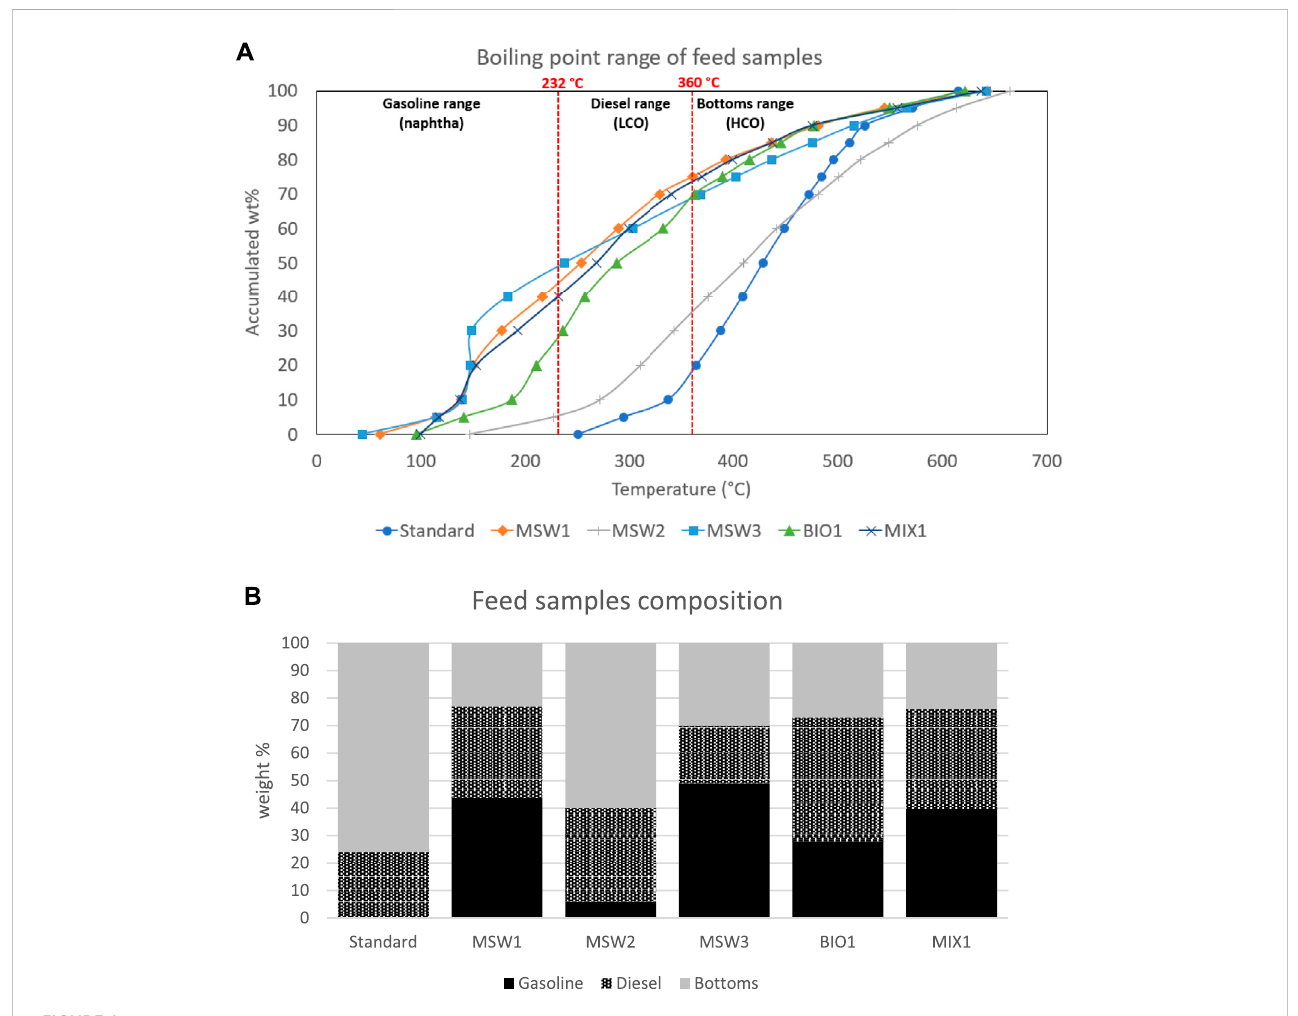
FIGURE 1 Standard and pyrolysis oil feed distillation curves (A) , top and component breakdown (B) , bottom.